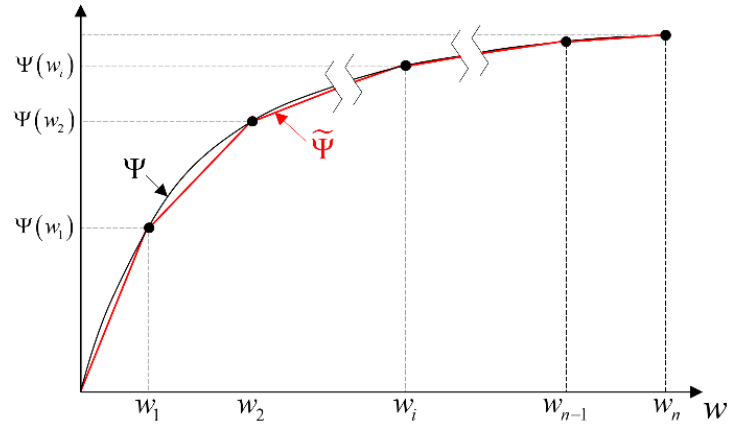
Figure A1. Piecewise representation of a nonlinear function 𝜓 .